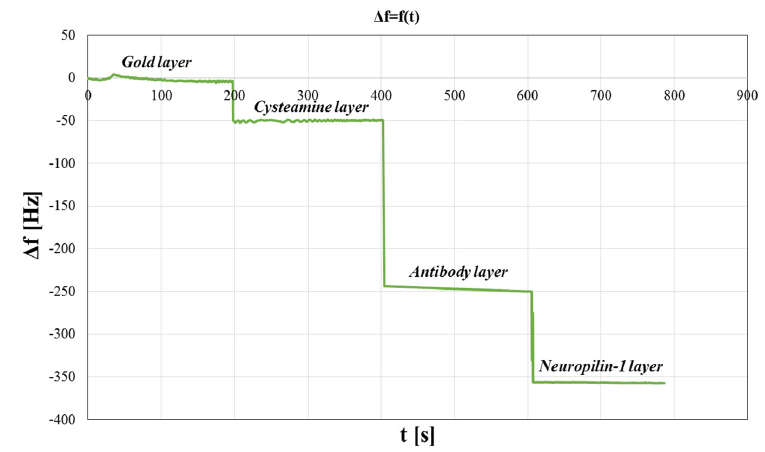
Figure 5. QCM studies of the biosensors surface. Variation of frequency as a function of time.